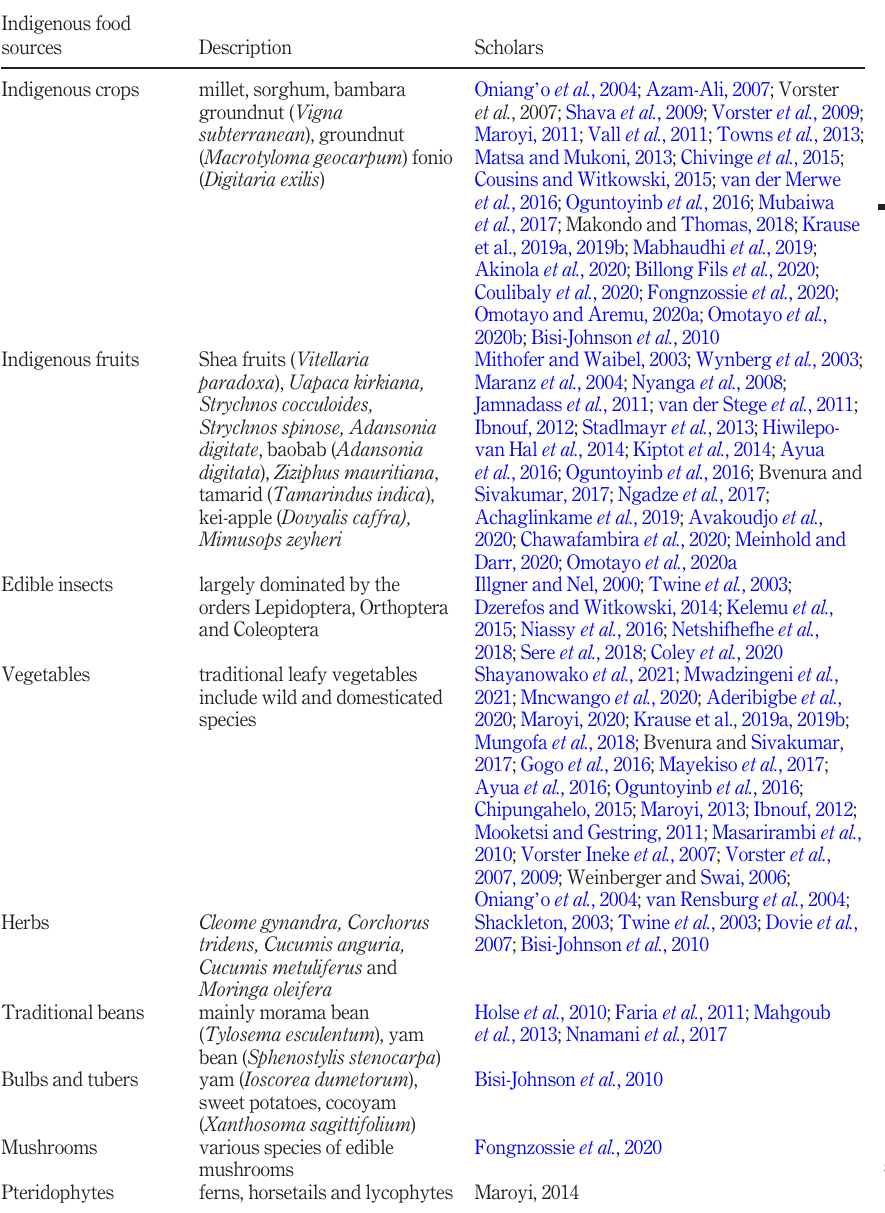
Table 2. Indigenous food sources used for food security in